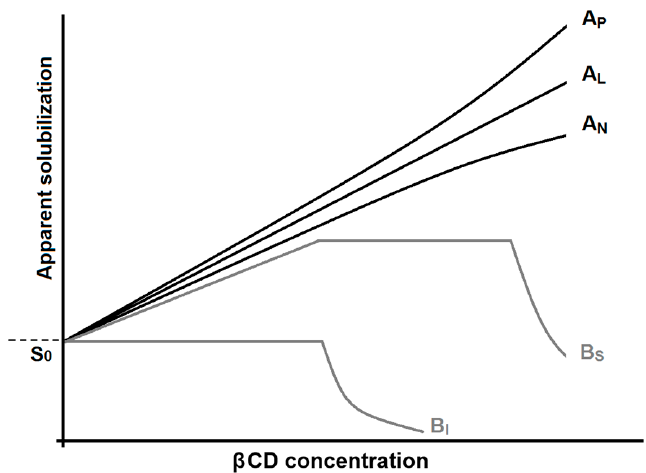
Figure 3. Phase-solubility diagrams associated with CDs. S 0 represents the thermodynamic solubility of the chemical entity in the absence of CDs. If complexation is effective and the complex formed results water-soluble, the substrates’ apparent solubility increases (A types). If the complexation is inefficient or the complex formed is poorly soluble, the solubility of the substrate decreases (B type).